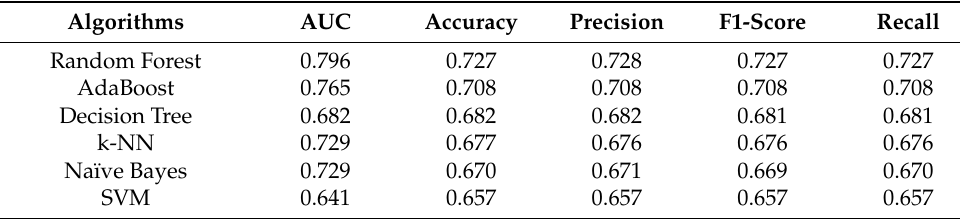
Table 4. Performance metrics applying 10-fold stratified